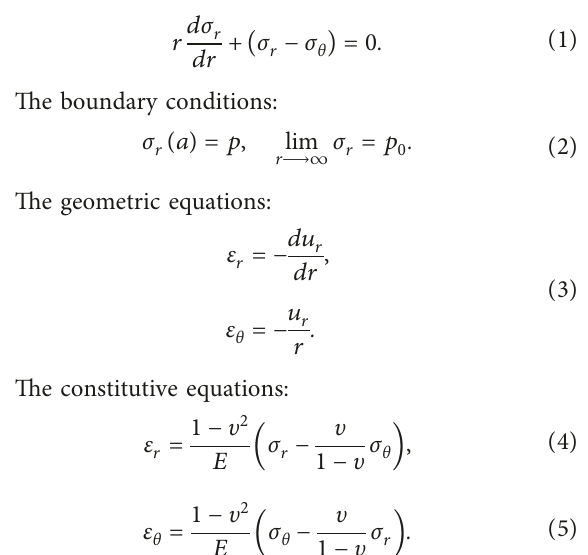
Figure 6: Axial force curve of S1.